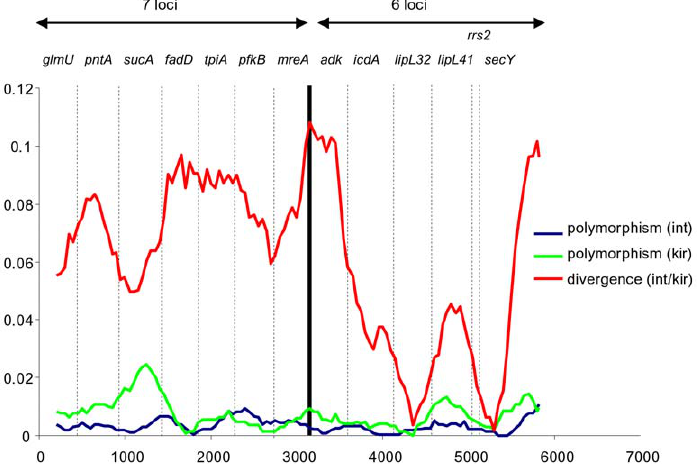
Figure 1. Sliding window analysis of concatenated sequence of all 13 loci. Sliding window analysis of concatenated sequence of all 13 loci, carried out using DNAsp v 5 using a window size of 400-bp, a step size of 50-bp, and points based on the mid-point of each window (i.e. the first point is at position 200). The names of the individual loci are shown. Three plots are given to represent the level of polymorphism within each of the two species, and the level of diversity between them. In terms of the within species variation, there is little difference between the two schemes and both point to generally higher levels of variation within L. kirschneri than L. interrogans . However, there are two loci used in the 6L scheme that are highly conserved between species ( lipL32 and rrs2 ), which means that in general the 7L scheme provides better between-species resolution.